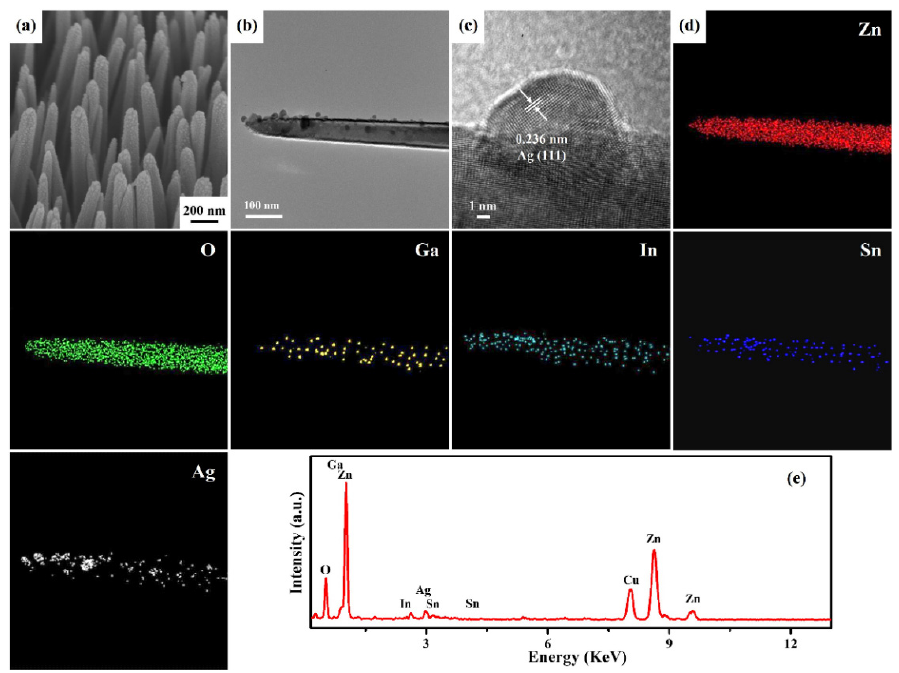
Figure 5. ( a ) The tilt-view FESEM image of ZnO: Ga@ITO@Ag nanotowers. ( b ) FETEM, ( c ) HRTEM,